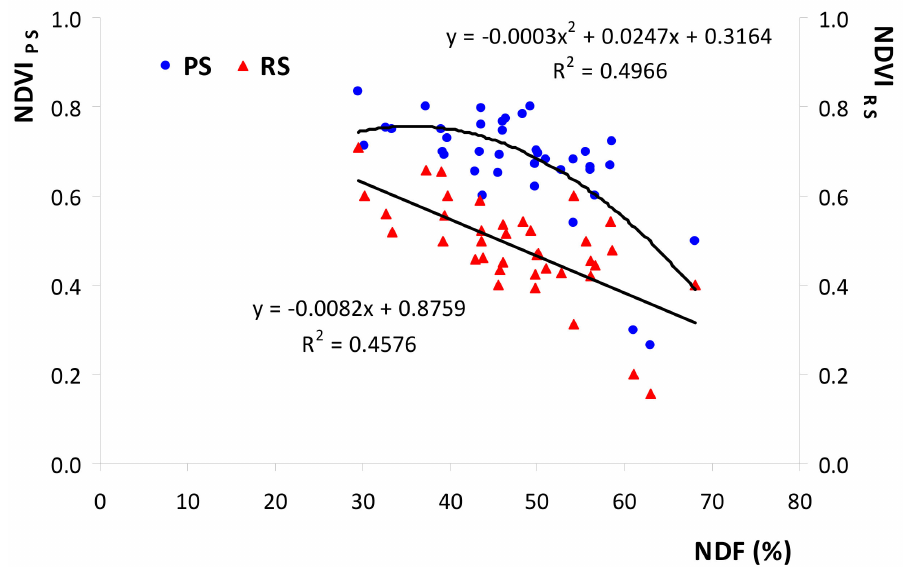
Figure 11. Correlation between vegetation index values (obtained by proximal sensors, NDVI PS , and by remote sensing, NDVI RS ) and pasture neutral detergent fibre